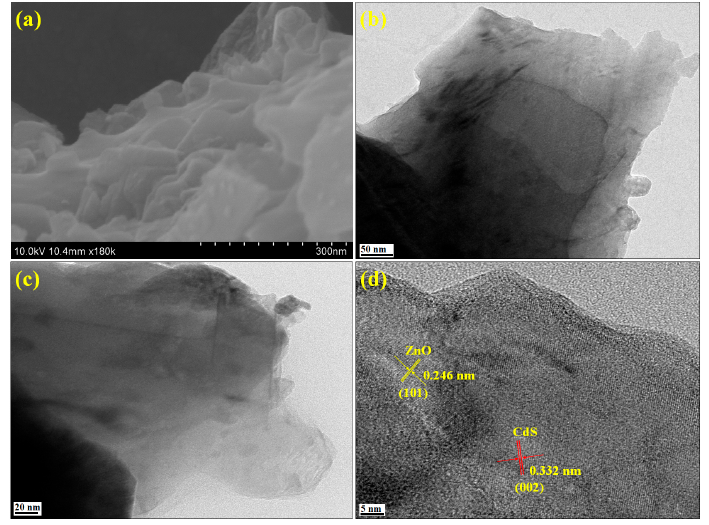
Figure 2. ( a ) SEM, ( b ) TEM, ( c ) HRTEM, and ( d ) lattice fringe pattern of Co-doped ZnO/CdS